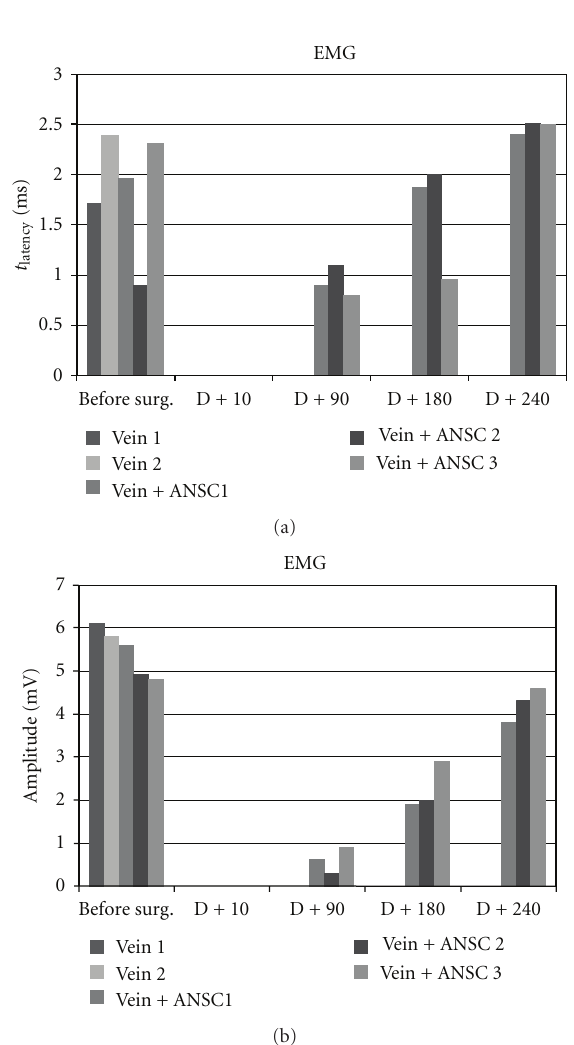
Figure 2: Electromyographic evaluation of muscle quadriceps femori at 90, 180, and 240 days following N. cruralis lesion and graft of GFP-labeled neurospheres inside a venous bridge before (“before surg.”) or after (“D + 90”, “D + 180”, “D + 240”) surgery.